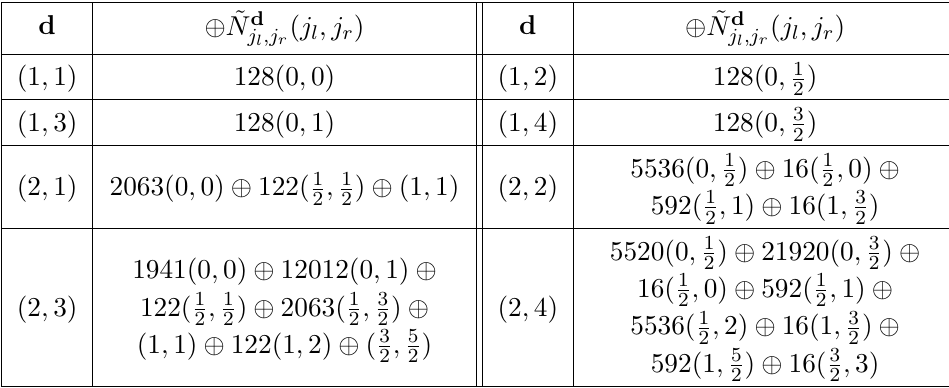
Table 18 . Spectrum of the fundamental Wilson loop operator in the E-string theory for ( d 1 , d 2 ) ≤ (2 , 4) . Here, d = ( d 1 , d 2 ) labels the BPS states with charge d 1 m 0 + d 2 φ . For convenience, we turn off all flavor mass parameters m i =1 , ··· , 8